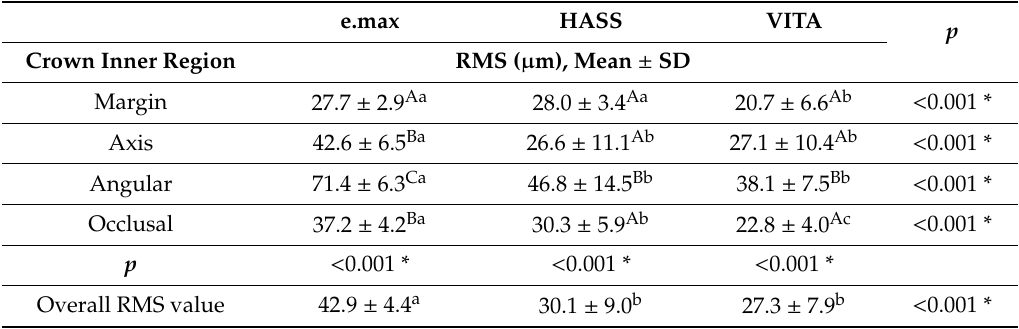
Table 2. Comparison of RMS values for di ff erent lithium disilicate blocks and crown inner regions.